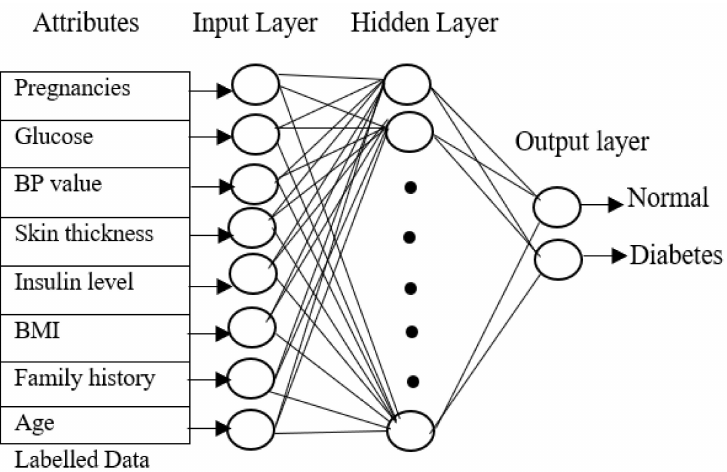
Figure 2. Neural network training